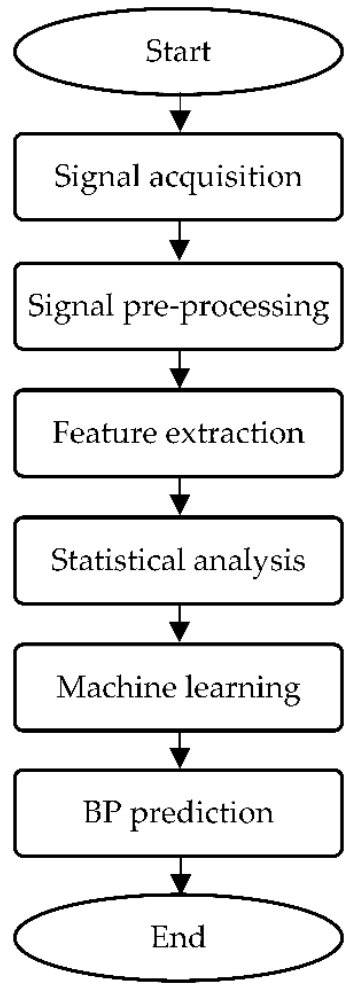
Figure 9. Flowchart of signal processing analysis for BP prediction.